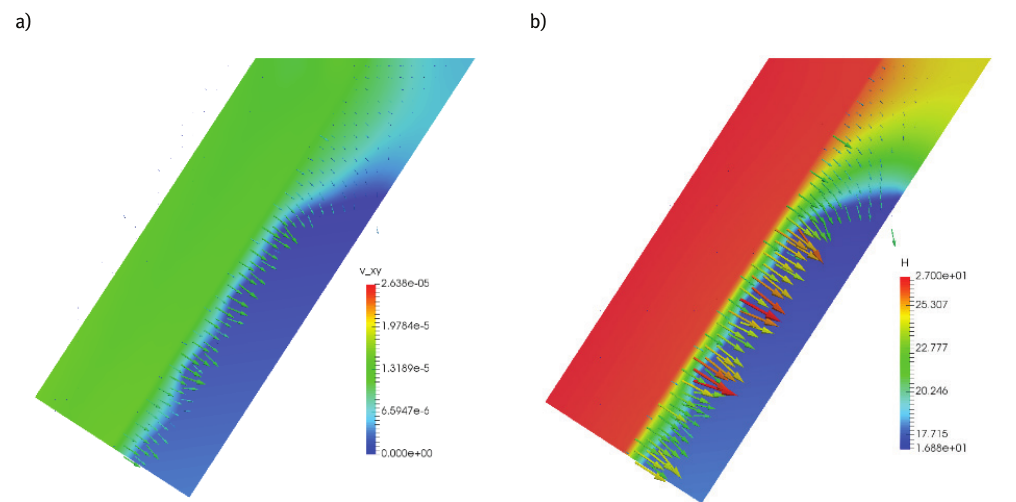
Figure 15: Isolines of hydraulic head and flow vectors in the gravel layer at 170 m above sea level after: a) 1 day, b) 15